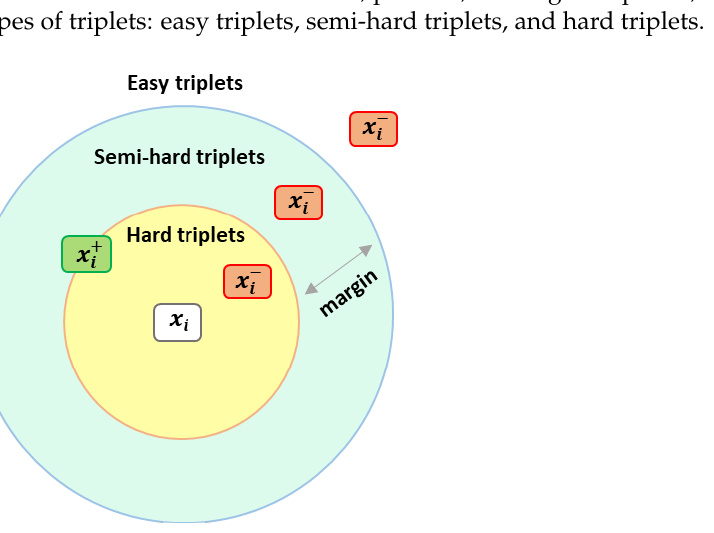
Figure 2. Three possible triplets depending on the distance between an anchor and a positive or a